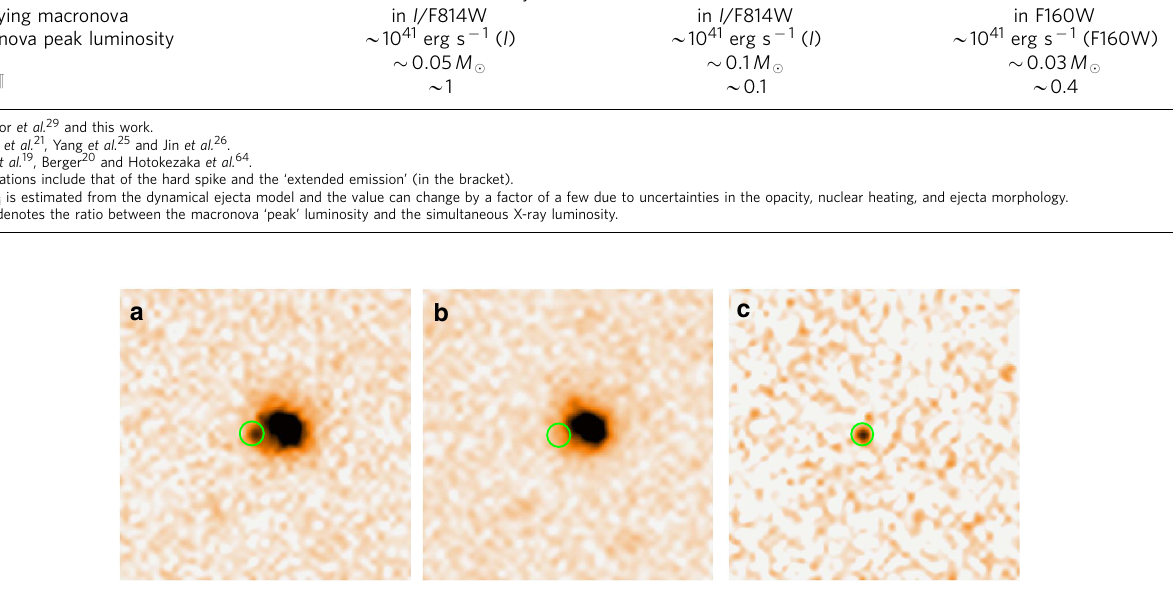
Figure 4 | The VLT I -band images of the afterglow of GRB 050709. The data were taken on 12 July 2005 ( a ) and 30 July 2005 ( b ), and the signal resulted in the image substraction ( c ). The afterglow position has been circled and the afterglow emission is clearly visible on 12 July 2005. The images are magnified only for